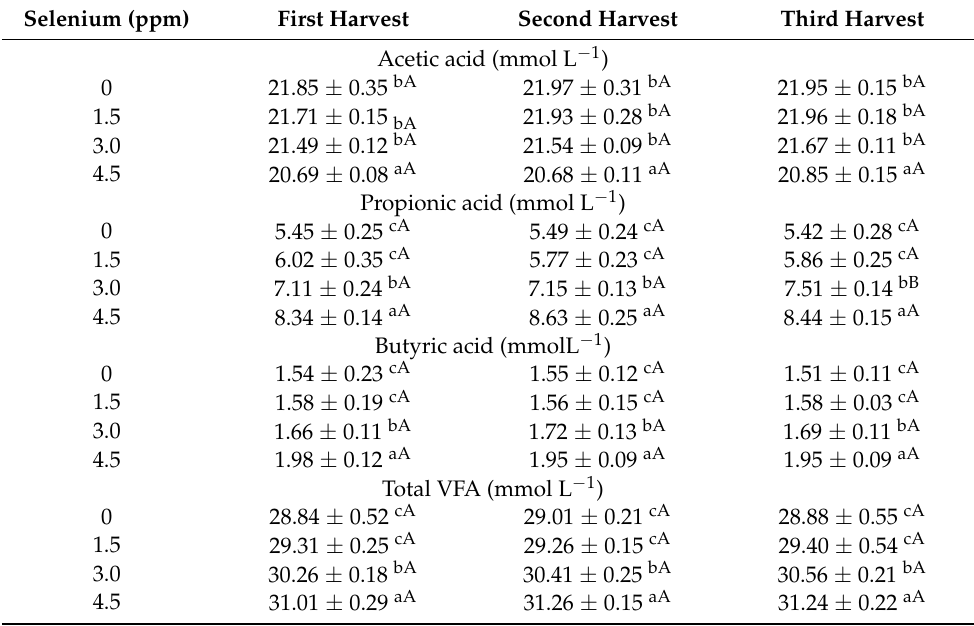
Table 4. Content of VFA after ruminal fermentation of Festuca arundinacea Schreb. whit